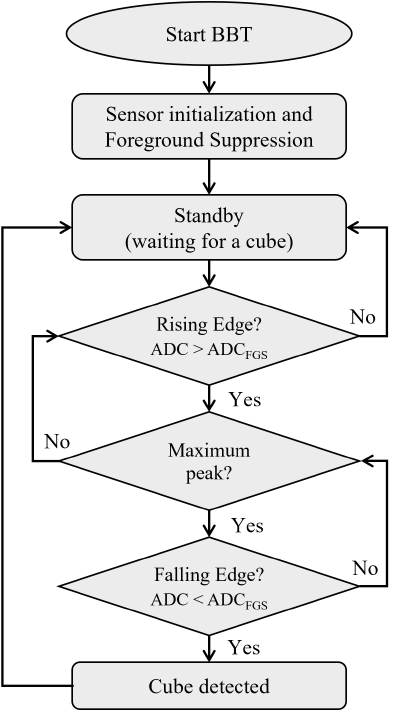
Figure 6. Flowchart for cube